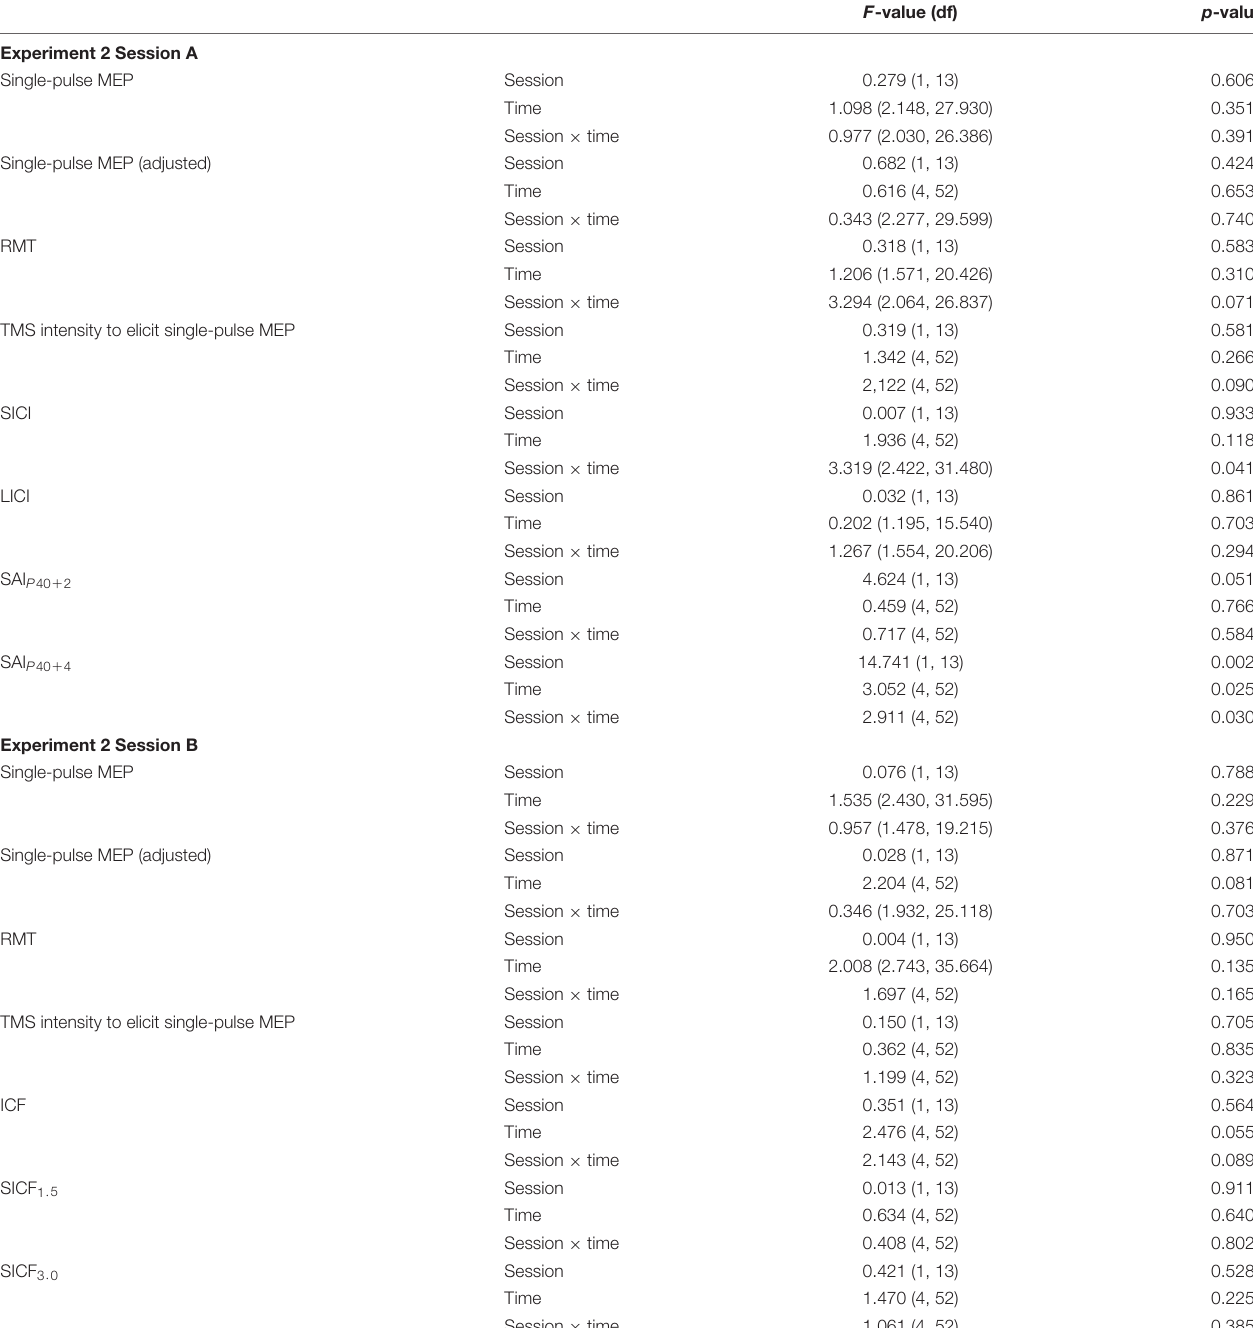
TABLE 4 | Results of repeated-measures analysis of variance for Experiment 2 (exercised leg